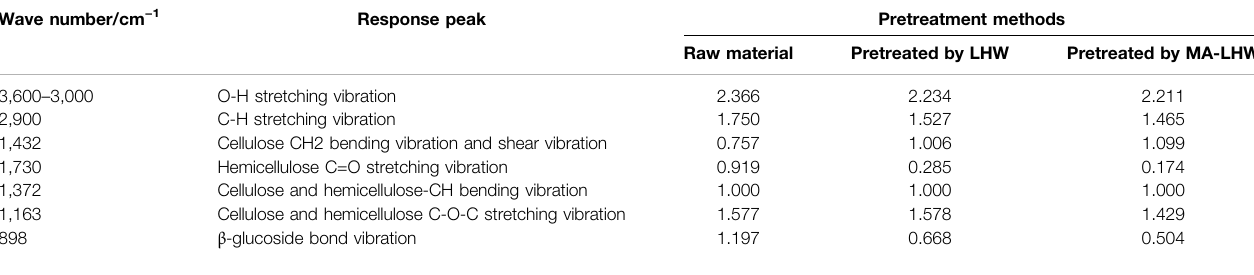
TABLE 3 | Structure attribution and relative strength of absorption peaks in IR spectra (Kim and Lee, 2005). Wave number/cm −